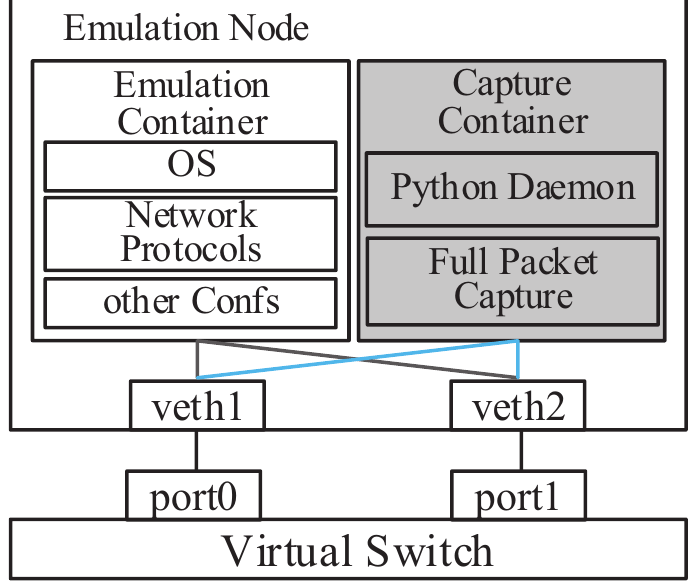
Figure 3. Emulation